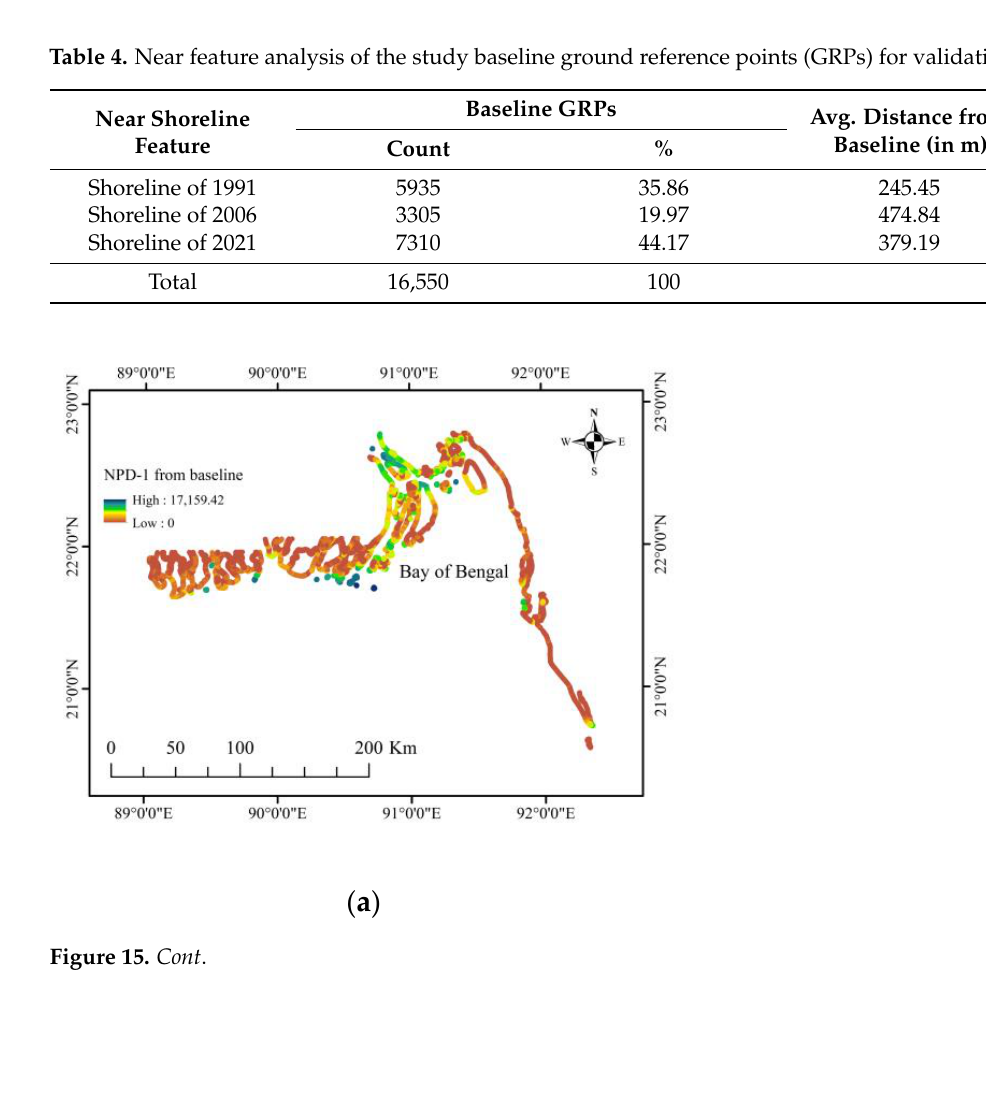
Table 4. Near feature analysis of the study baseline ground reference points (GRPs) for validation.